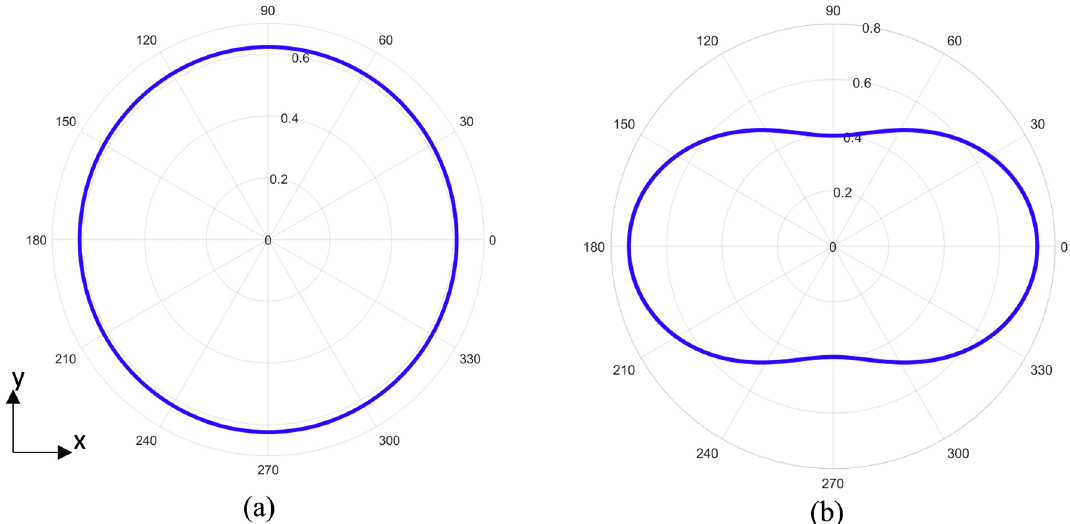
Figure 4. Calculated radiation patterns for the modified rotating dipole lasting ½ of a full orbital period (arbitrary scale) in the orbital plane. ( a ) Radiation pattern for normalized frequency equal to 1. The circular pattern is identical to the steady state rotating dipole in which the emitted frequency and angular velocity are equivalent. Power is distributed uniformly in the plane of rotation at this frequency. ( b ) Radiation pattern for normalized frequency equal to ~ 1.36. Power is distributed in all directions of the orbital plane, but is more biased along the x-axis.